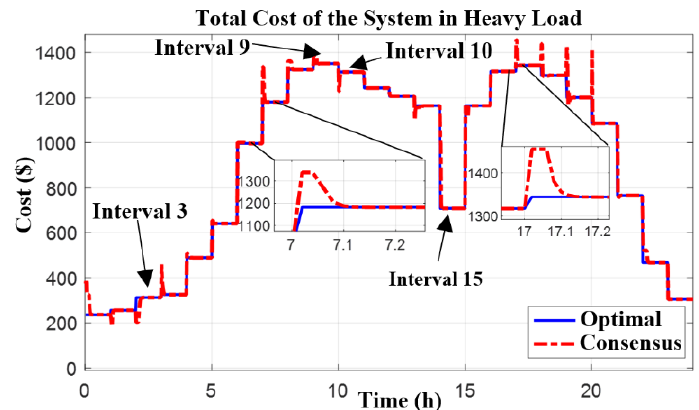
Figure 12. The total cost in heavy-load scenario.